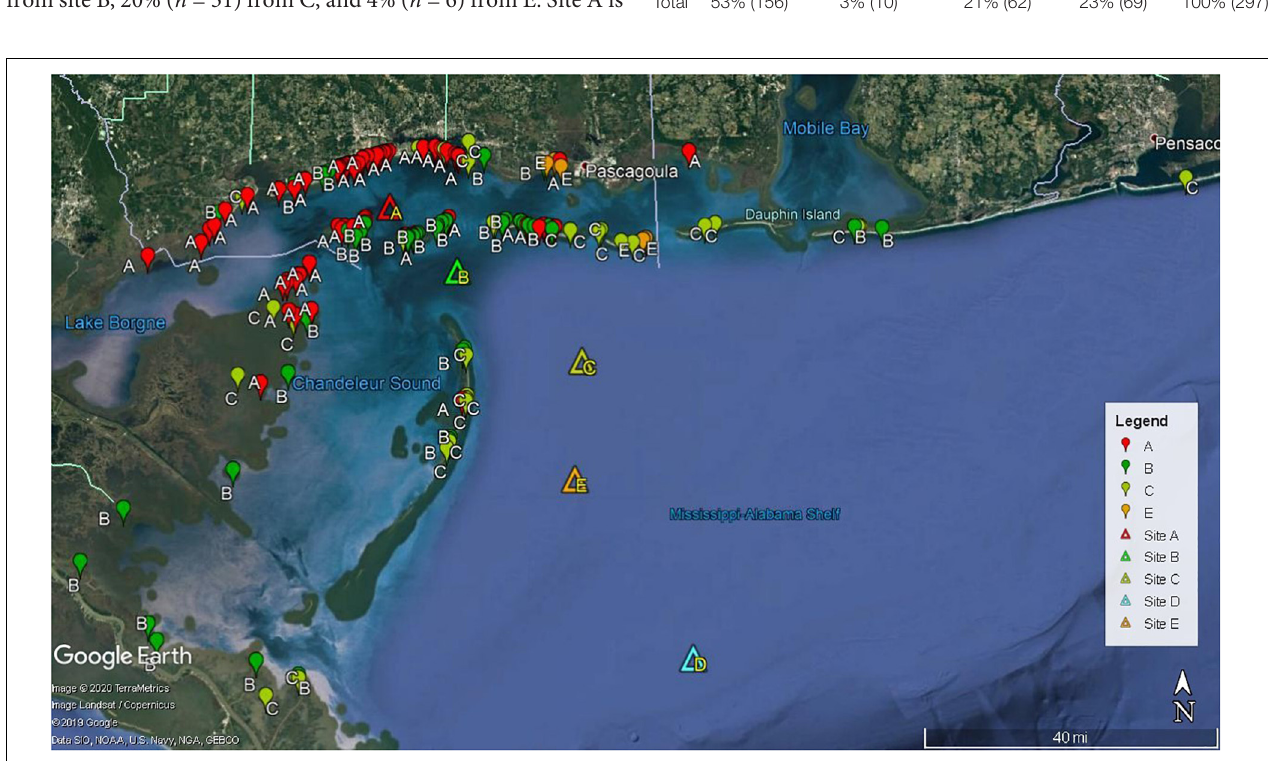
FIGURE 5 | Locations of beached sea turtle carcasses ( n = 64) and effigies ( n = 92) color coded by release site (triangles). The effigy that beached on Timbalier Island, LA is not shown.